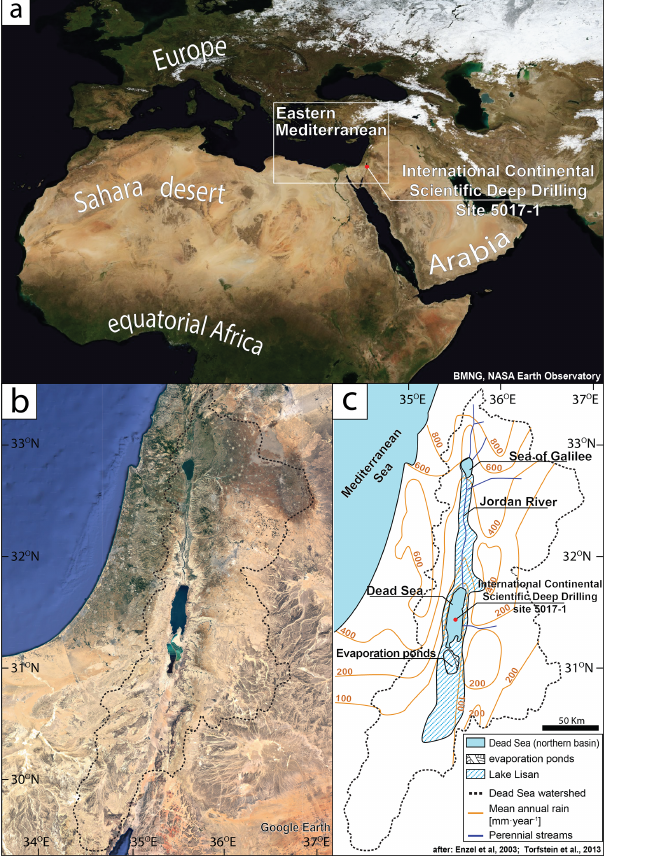
Figure 1. (a) Satellite image of the Mediterranean Sea and its sur- rounding depicting the pivotal location of the ICDP–DSDDP site 5017-1 on the seam of global climate belts (extracted from Stöckli et al., 2005). (b) Satellite image of the eastern Mediterranean depict- ing the sharp climatic gradient between the Mediterranean climate in the north (mean annual precipitation > 1000mmyr − 1 ) and the hyperarid south (mean annual precipitation < 100mmyr − 1 ; image from © Google Earth). (c) The Dead Sea watershed and the ex- tent of Lake Lisan during the Last Glacial Maximum (lake level ∼ 170mb.m.s.l.; ∼ 260m above modern level) with modern mean annual precipitation (after Enzel et al., 2003; Torfstein et al.,